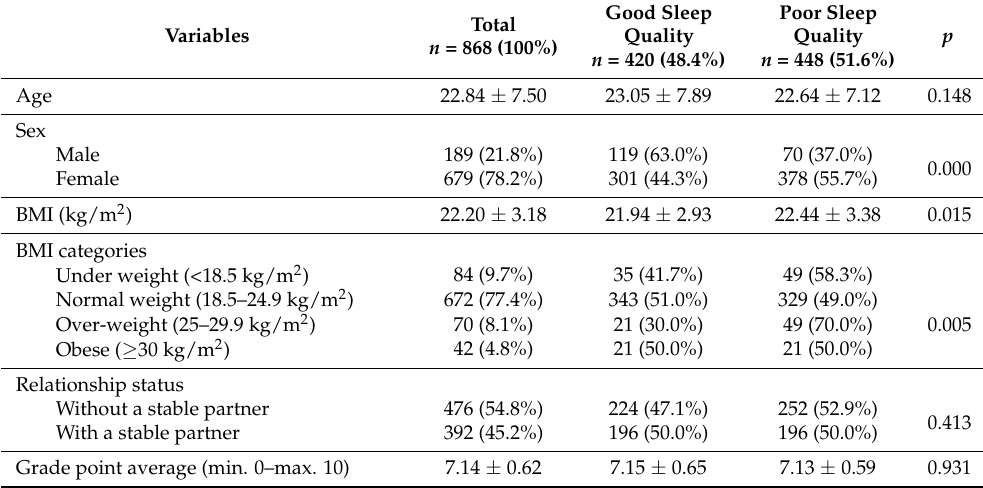
Table 1. Characteristics of the study population according to their sleep